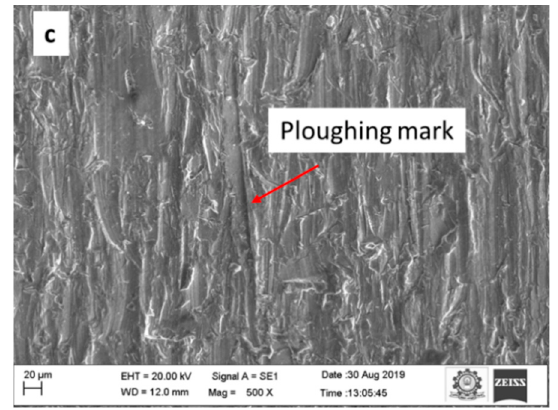
Figure 8. AWJM surface micrograph at SOD = 3 mm, JT = 5 mm/min, and P = 240 MPa ( a ) top, ( b ) middle, and ( c ) bottom region.